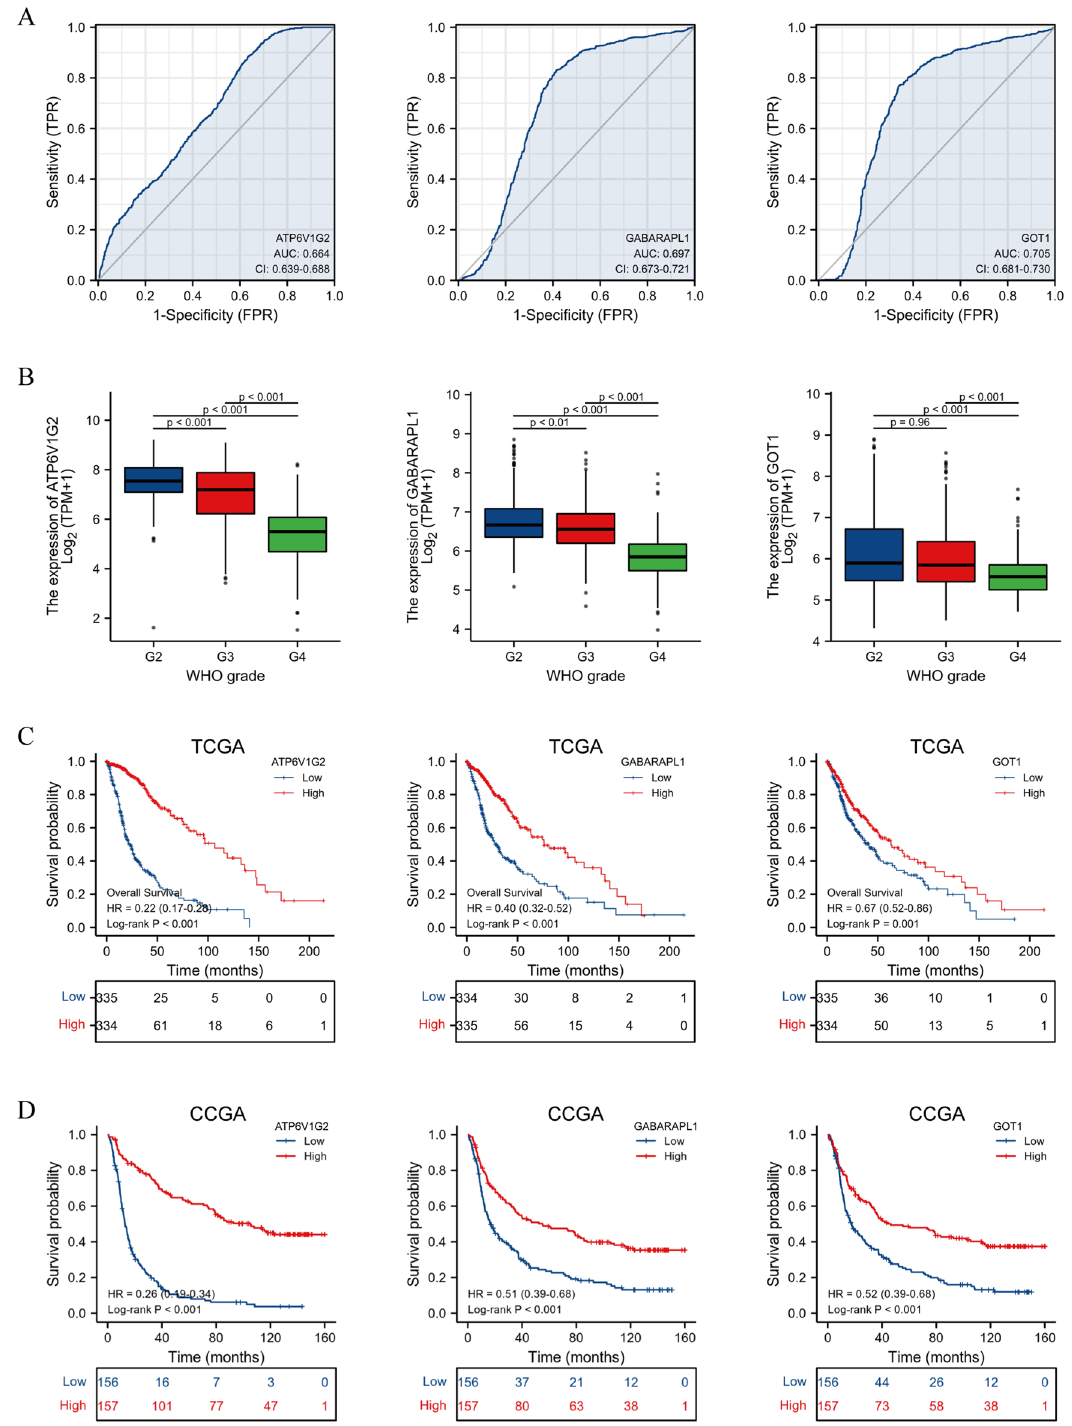
Figure 8. Association of hub genes expression and clinical variables. ( A ) ROC curves of hub genes in TCGA and GTEx database. ( B ) Expression of hub genes at different grades of glioma in TCGA database. ( C ) K-M curves of hub genes in TCGA database. ( D ) K-M curves of hub genes in CGGA than that of ATP6V1G2 alone. DCA plots likewise confirmed the nomogram combined with various features had considerable clinical application value (Fig. 10D).